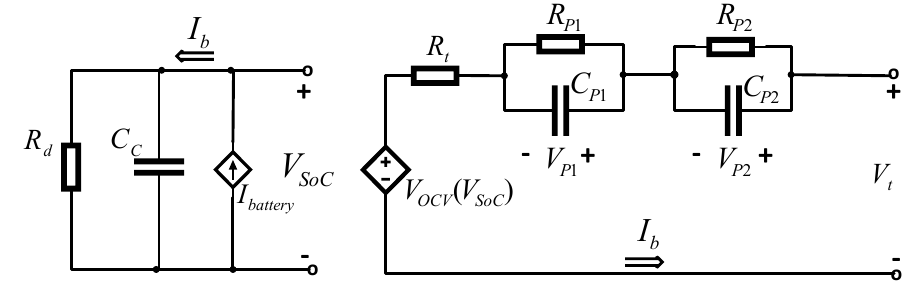
Figure 6. Source-dependent ECM.